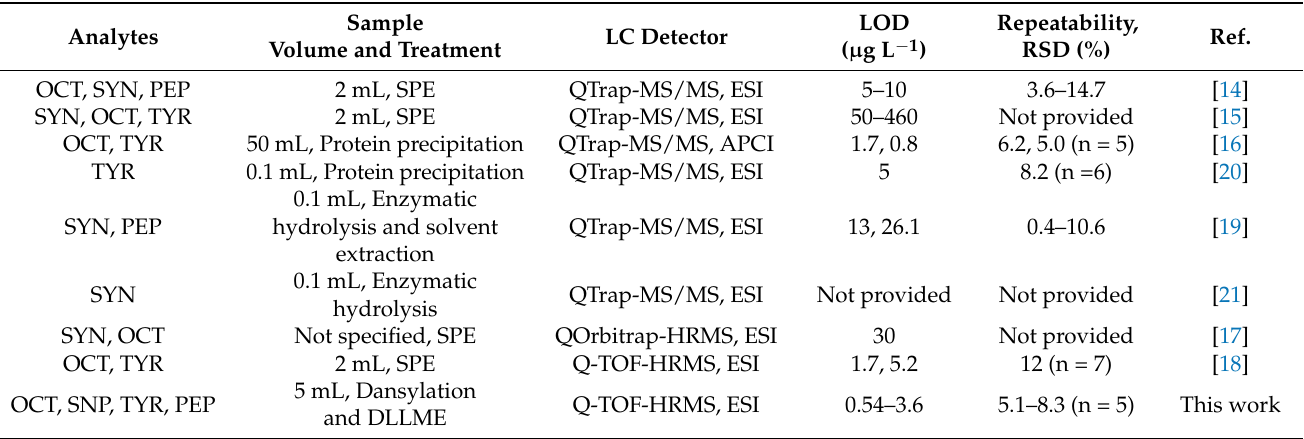
Table 4. Comparison of the proposed method with others previously published for BA determination in urine using LC.